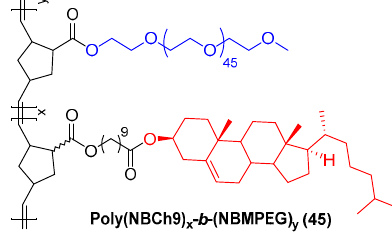
Figure 4. Cholesterol-based brush block copolymer poly(NBCh9) x - b -(NBMPEG) y .